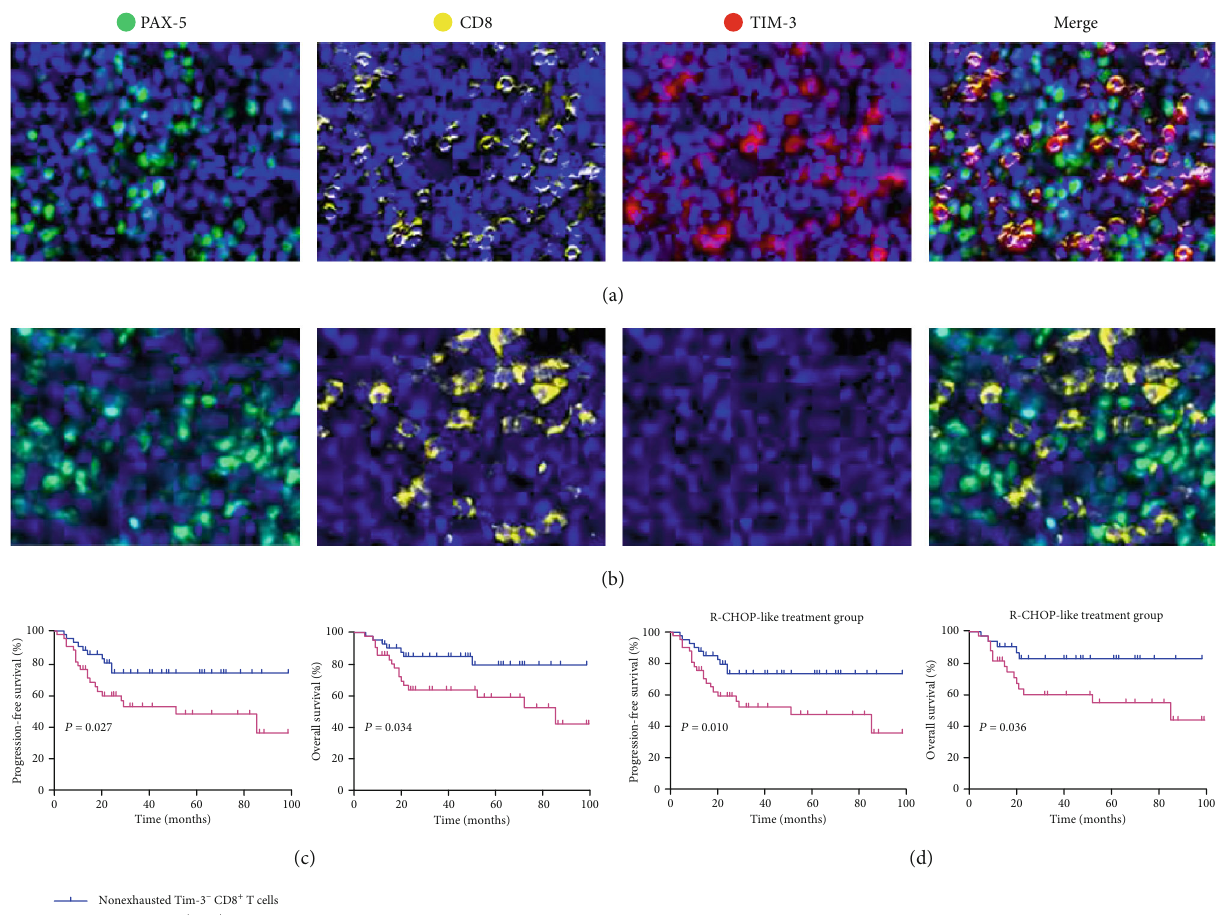
Figure 4: Exhausted Tim-3 + CD8 + T cells and nonexhausted Tim-3 - CD8 + T cells and survival of patients with DLBCL. (a, b) Representative fl uorescence microscopy images of exhausted Tim-3 - CD8 + T cells and nonexhausted Tim-3 - CD8 + T cells. (c) Kaplan-Meier curves for PFS and OS of “ immune-in fl amed phenotype ” patients with DLBCL and exhausted Tim-3 + CD8 + T cells and nonexhausted Tim-3 - CD8 + T cells ( n = 82 ). (d) Kaplan-Meier curves for PFS and OS of patients with DLBCL and exhausted Tim-3 + CD8 + T cells and nonexhausted Tim-3 - CD8 + T cells in the R-CHOP-like treatment subgroup ( n = 63 ). DAPI (blue), PAX-5 (green), CD8 (yellow), and Tim-3 (red) were stained. Scans were imaged at 200x magni fi cation. Log-rank test was used to determine the signi fi cance of comparison between two